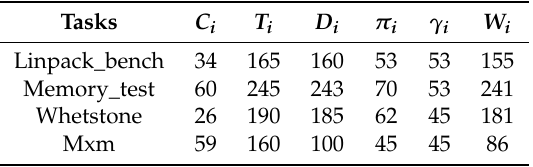
Table 2. The attributes of four benchmarks.